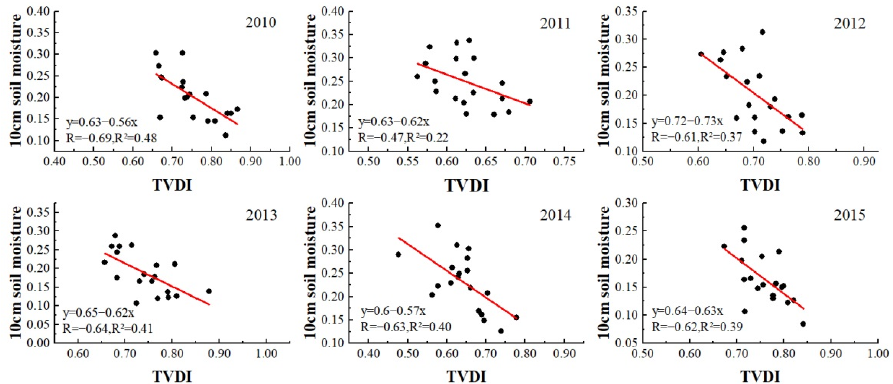
Figure 3. Correlation between TVDI retrieved directly without geomorphological division and 10 cm soil moisture in summer from 2010 to 2015.